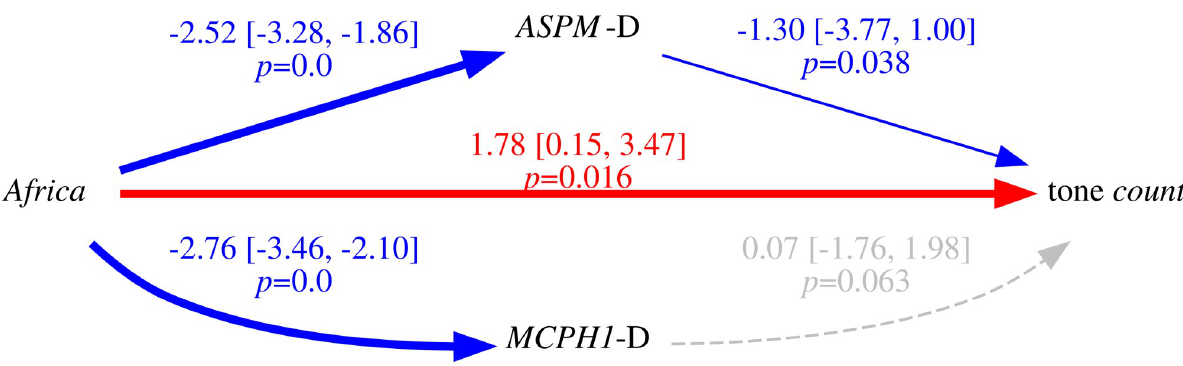
Fig 29. The simultaneous mediation model for tone counts through both “derived” alleles. Same conventions as in Fig 12.